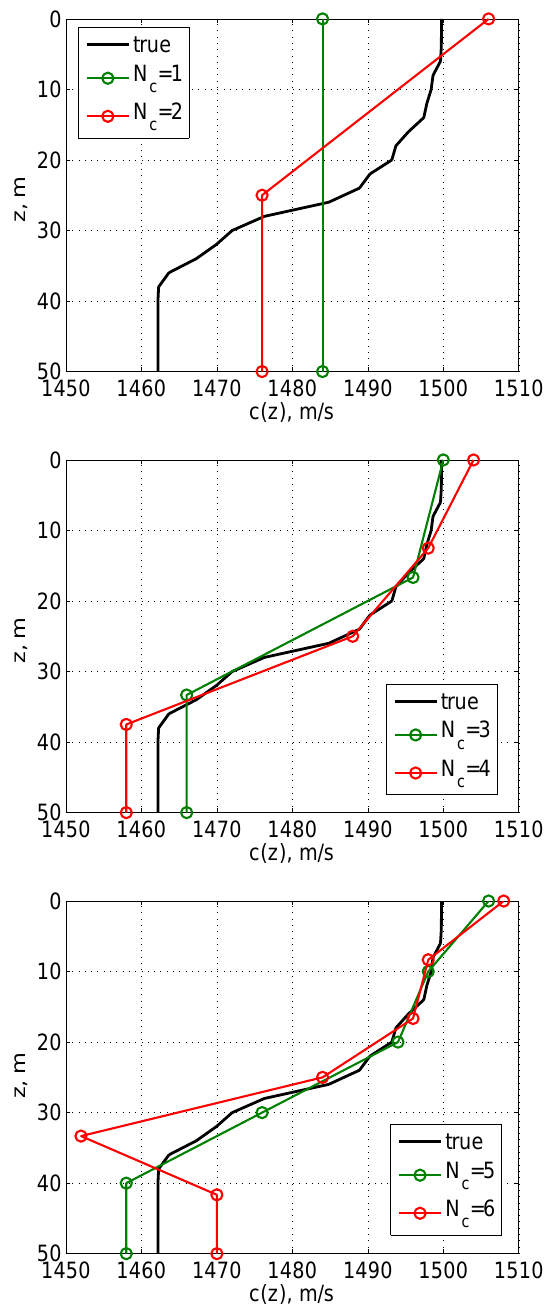
Table 1: Results of geoacoustic inversion for different values of N c